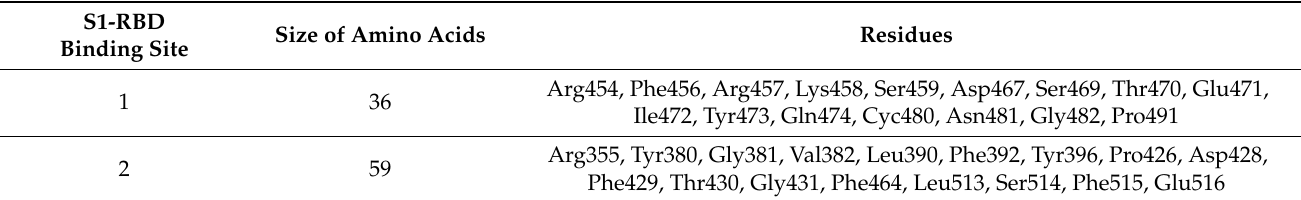
Table 4. Binding site residues of the SARS-CoV-2 S1-RBD region (6M0J) identified using